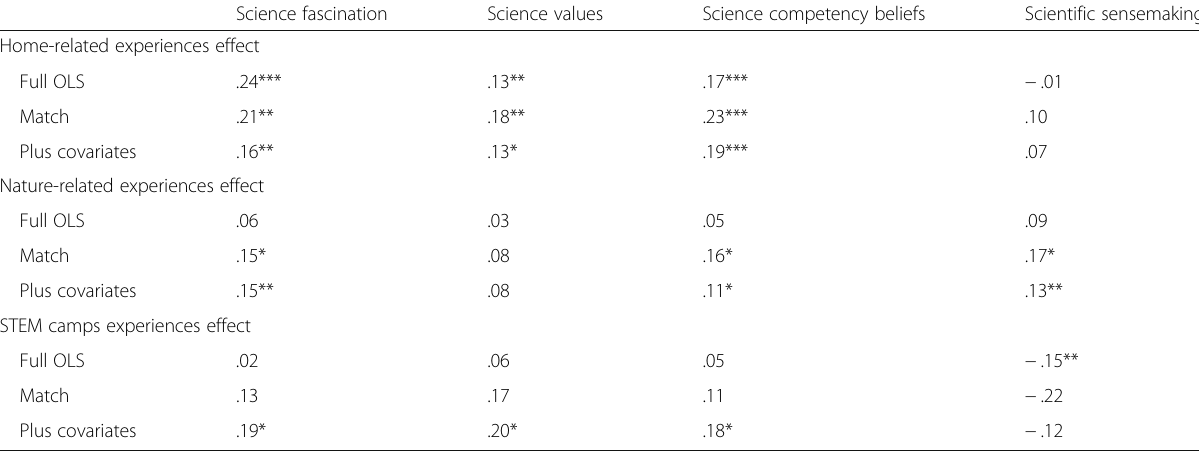
Table 7 Beta coefficients for the full OLS and matching regression models (without and then with the addition of the covariates) Science fascination Science values Science competency beliefs Scientific